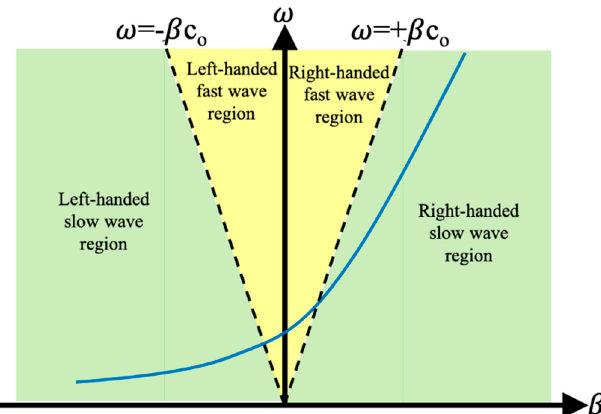
Figure 3. Dispersion diagram of CRLH TL (balanced case).